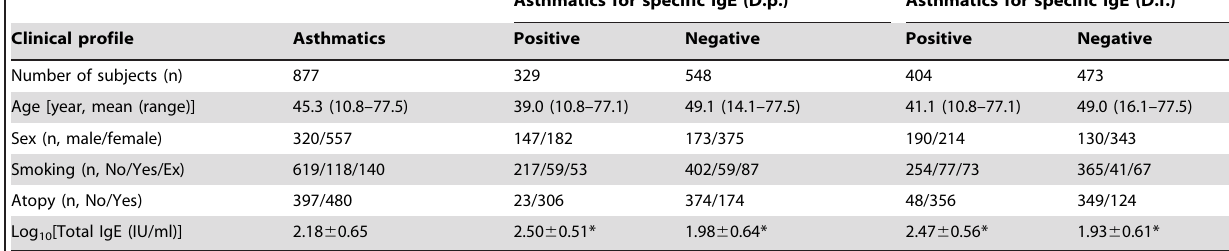
Asthmatics for specific IgE (D.p.)